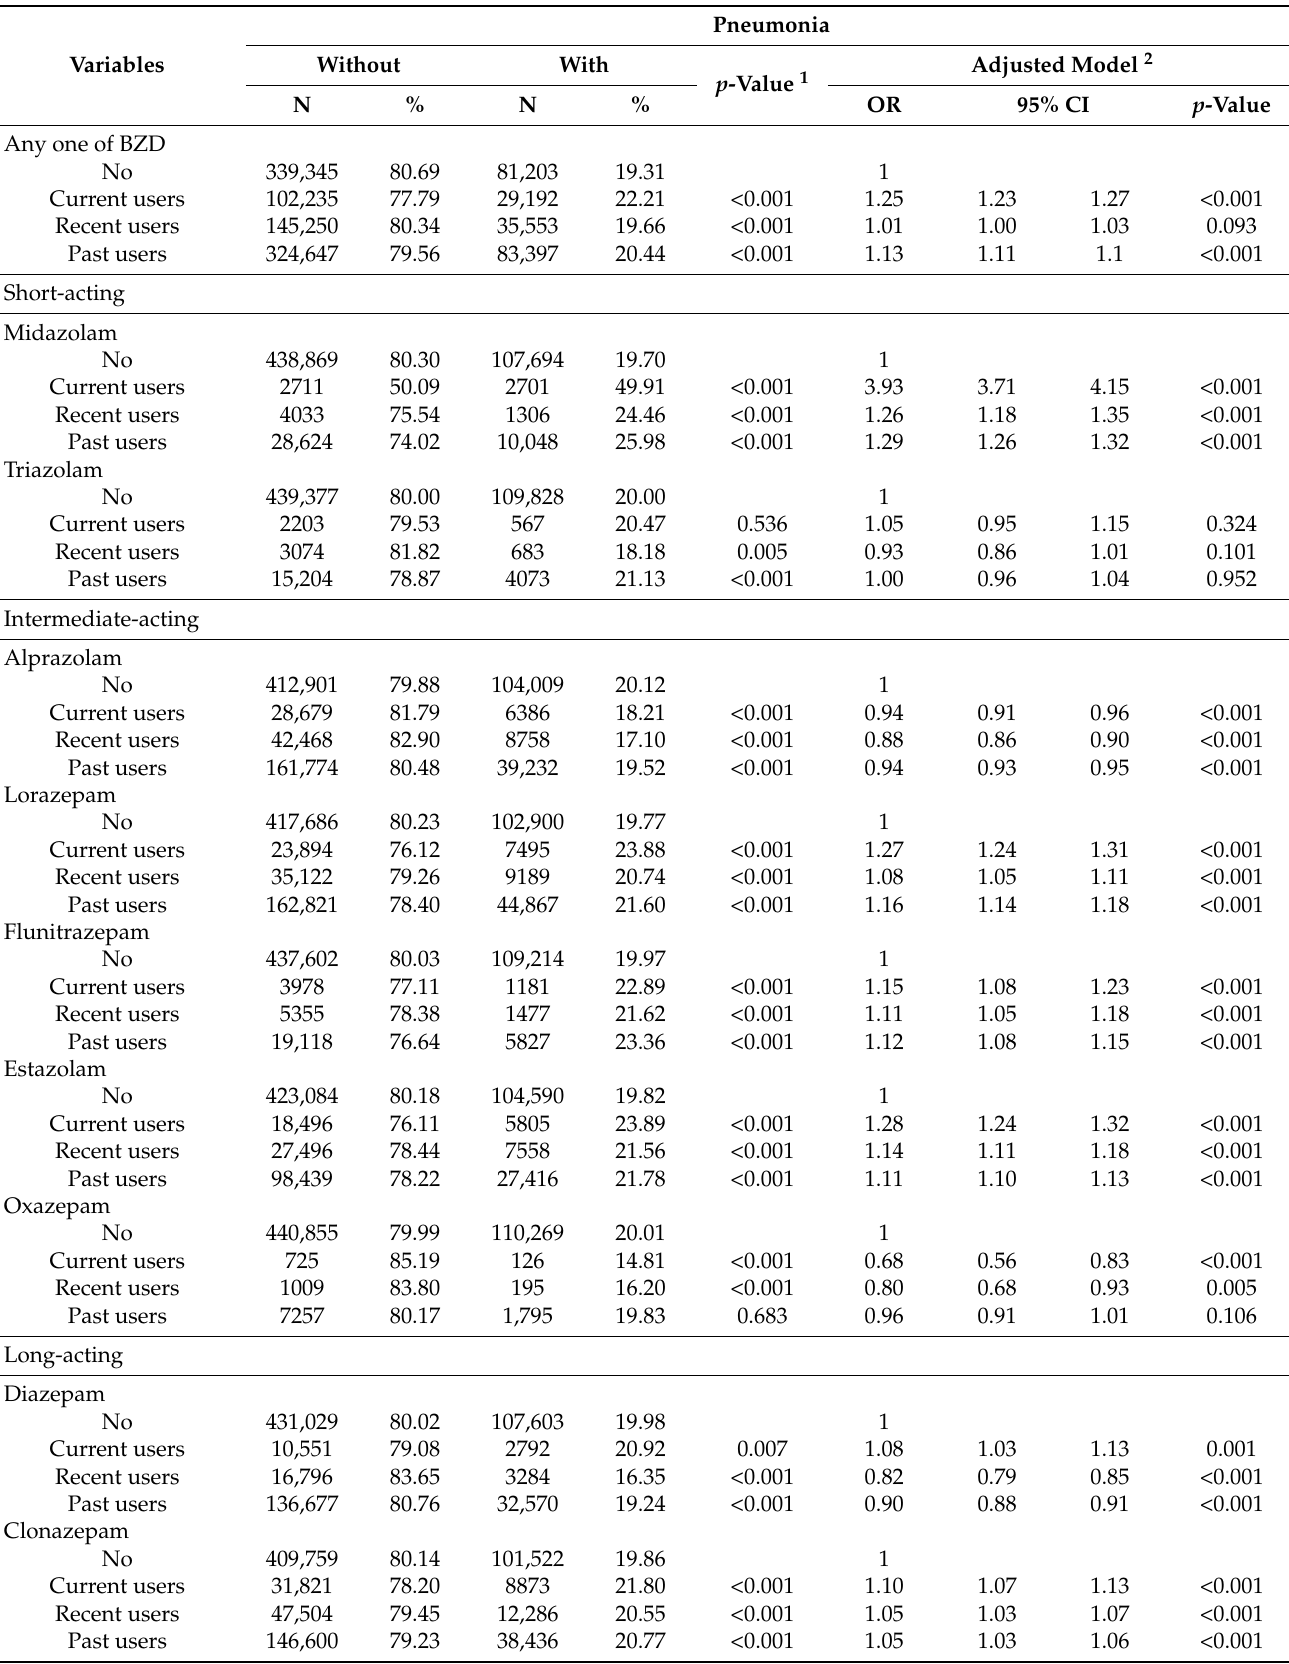
Table 2. Pneumonia risk associated with benzodiazepines